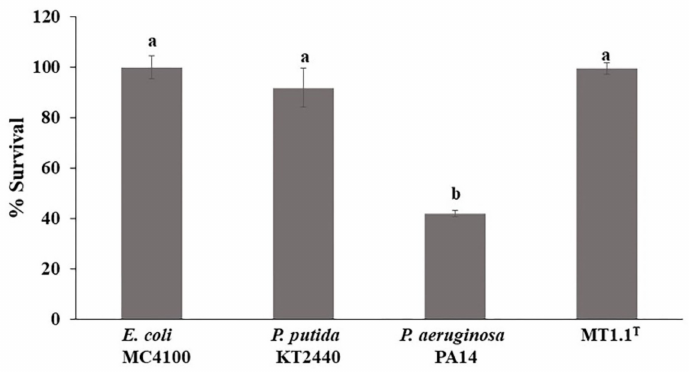
Figure 5. Escherichia coli MC4100 sensitivity. Different letters (a,b) indicate a significant difference according to Duncan at p <